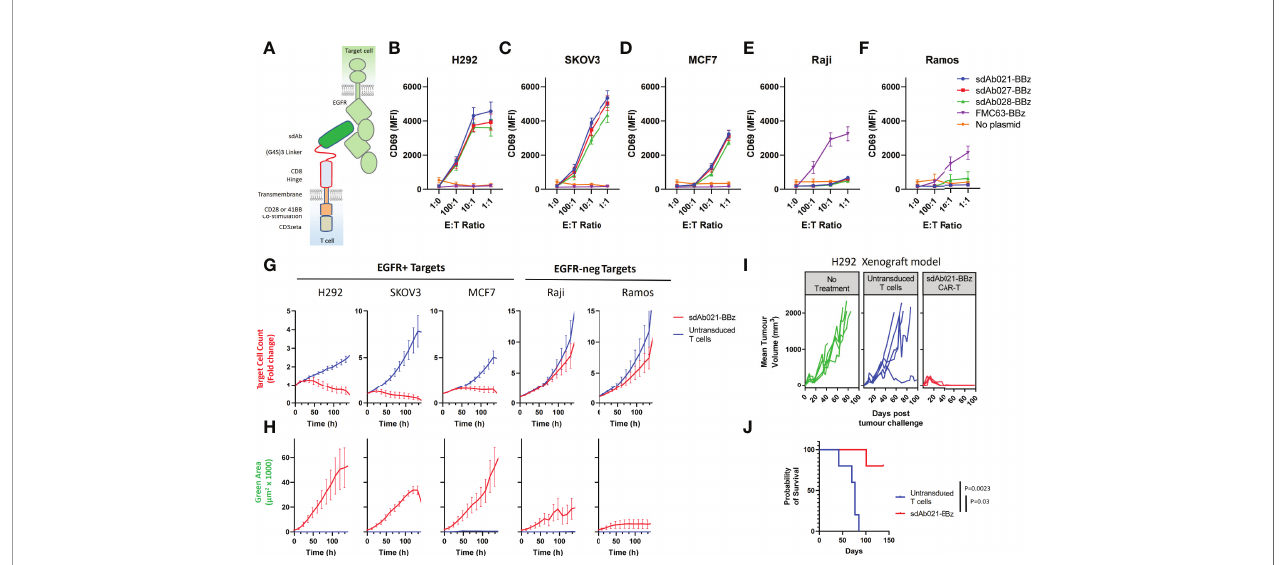
FIGURE 1 | Identi fi cation of EGFR-speci fi c sdAbs with CAR functionality. (A) The structural elements of human EGFR and anti EGFR-sdAb CAR tested in this study are shown. Three EGFR-speci fi c sdAbs were cloned into a modular CAR backbone with 41BB and CD3z signaling domain via golden gate cloning. Jurkat cells were then electroporated with the resulting constructs. Control cells with no plasmid or with a CD19 (FMC63) scFv CAR were also tested here. Jurkat cells (30 000/well) transiently expressing various CAR plasmids as shown were co-cultured with varying doses of (B, C) EGFR-high H292 or SKOV3 cells, (D) EGFR-low MCF7 cells, (E, F) EGFR-negative Raji cells or Ramos Cells and examined for activation via staining with APC-labelled anti-human CD69 antibody. CAR-J results show the mean +/- SEM from a three independent experiments performed in duplicate. Primary human T cells were then transduced with lentivirus encoding the sdAb021-EGFR- sdCAR construct and tested for activity against mKate2-expressing target cells with varying EGFR expression. (G) Automated fl uorescent counting was used to examine CAR-T mediated target cell killing and (H) expansion of EGFP-labelled CAR-T cells. Primary CAR-T results show the mean of 3 experiments performed in duplicate. NSG mice were injected with 6x10 6 H292 human lung cancer cells subcutaneously, then treated with 5x10 6 sdAb021-BBz CAR-T or untransduced control T cells intravenously (n=5 mice/group). (I) Growth of H292 tumors via regular caliper measurements is shown. (J) Probability of survival throughout the experiment is shown (P values are derived from a Mantel-Cox comparison of treatment